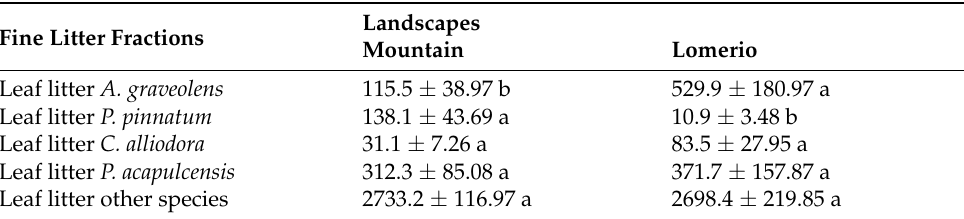
Table 2. Annual contributions of fine litterfall (kg ha − 1 y − 1 ) in landscapes of Magdalena, Colombia. The similar letters indicate no statistically significant differences ( p > 0.05). Mean ± SE ( n = 9 plots for Mountain landscapes, and n = 12 plots for Lomerio